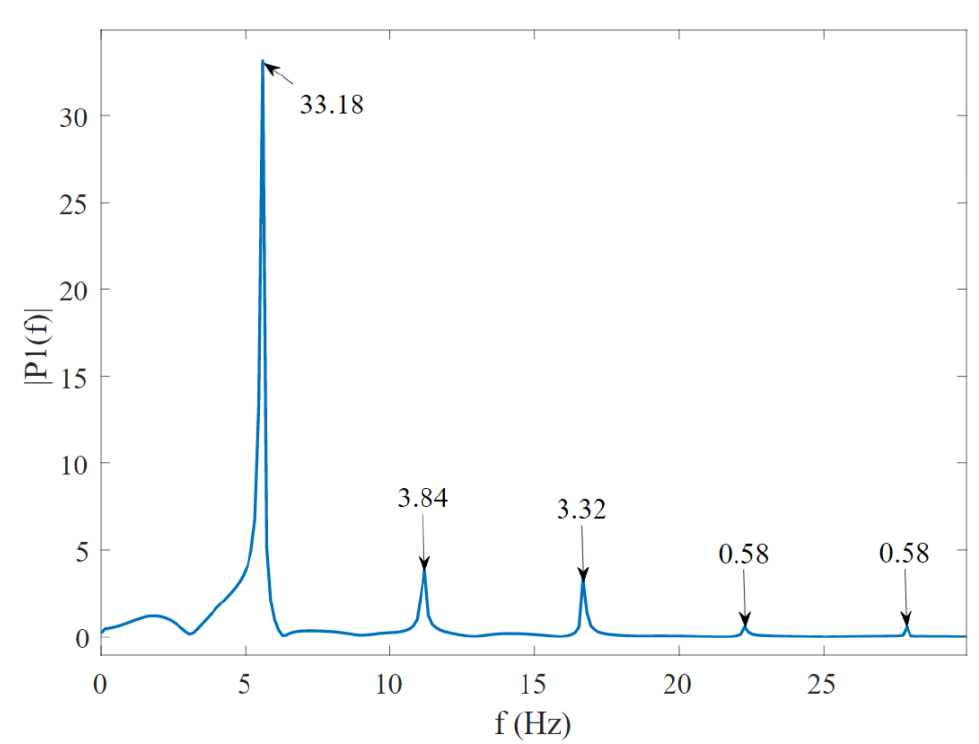
Figure 11. The Fast Fourier Transform on the signal to compute total harmonic distortion (THD) showing fundamental frequency and